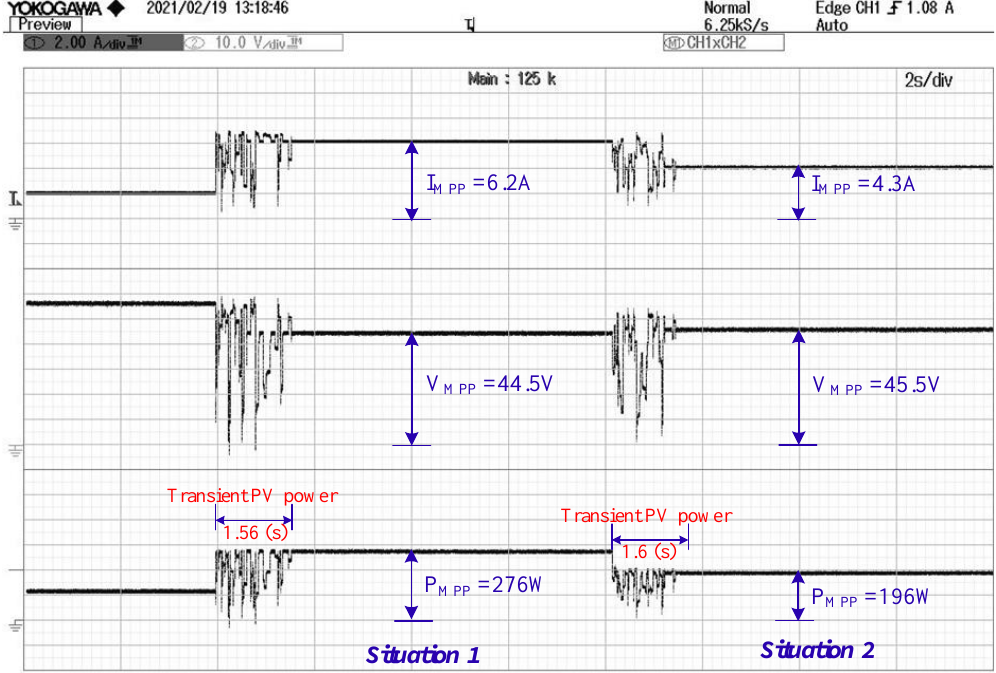
Figure 14. Experimental results of the PSO method (top to bottom: PV current, PV voltage, PV power).